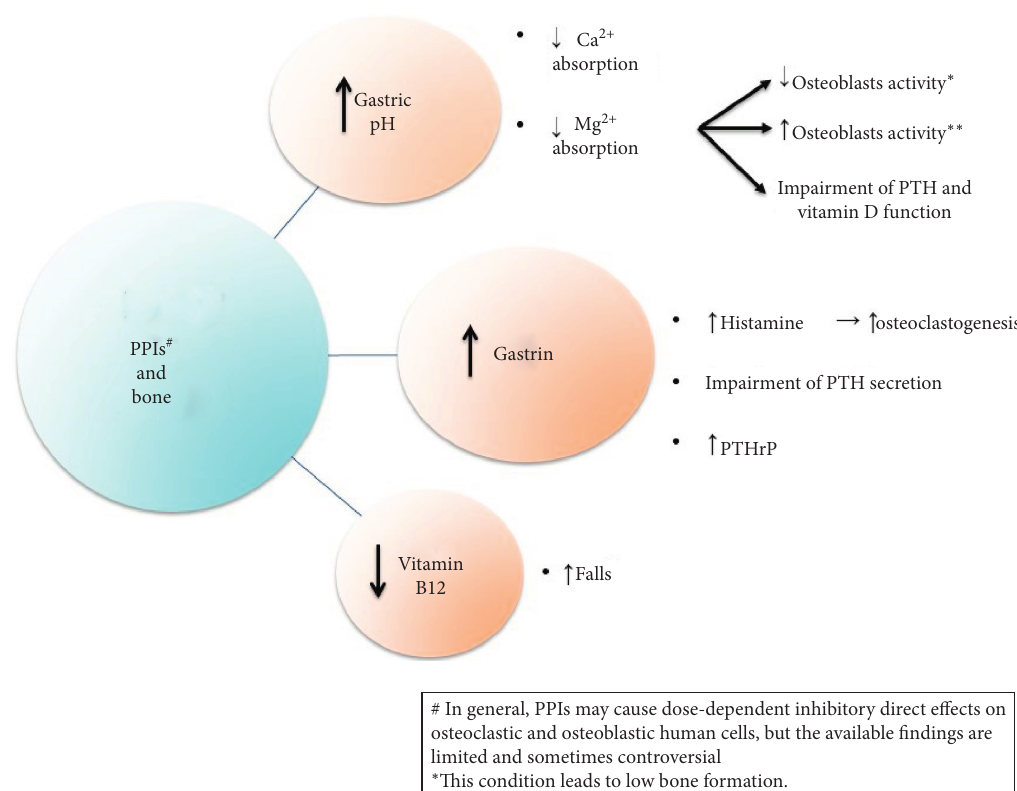
Figure 2: Potential mechanisms of PPIs induced fracture risk.